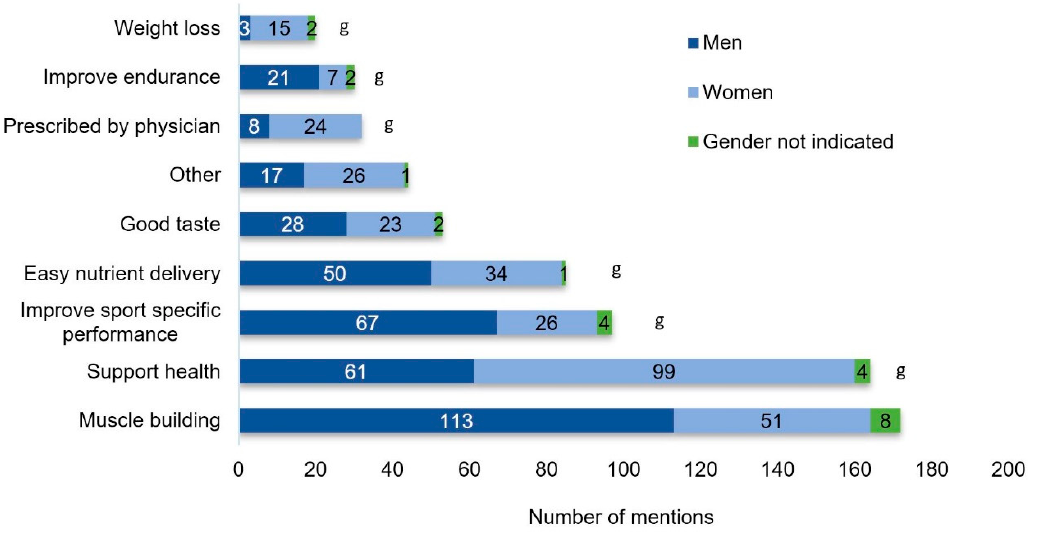
Figure 3. Reasons for supplement use. g: Indicates significant gender effect ( p < 0.05). Multiple answers were possible.